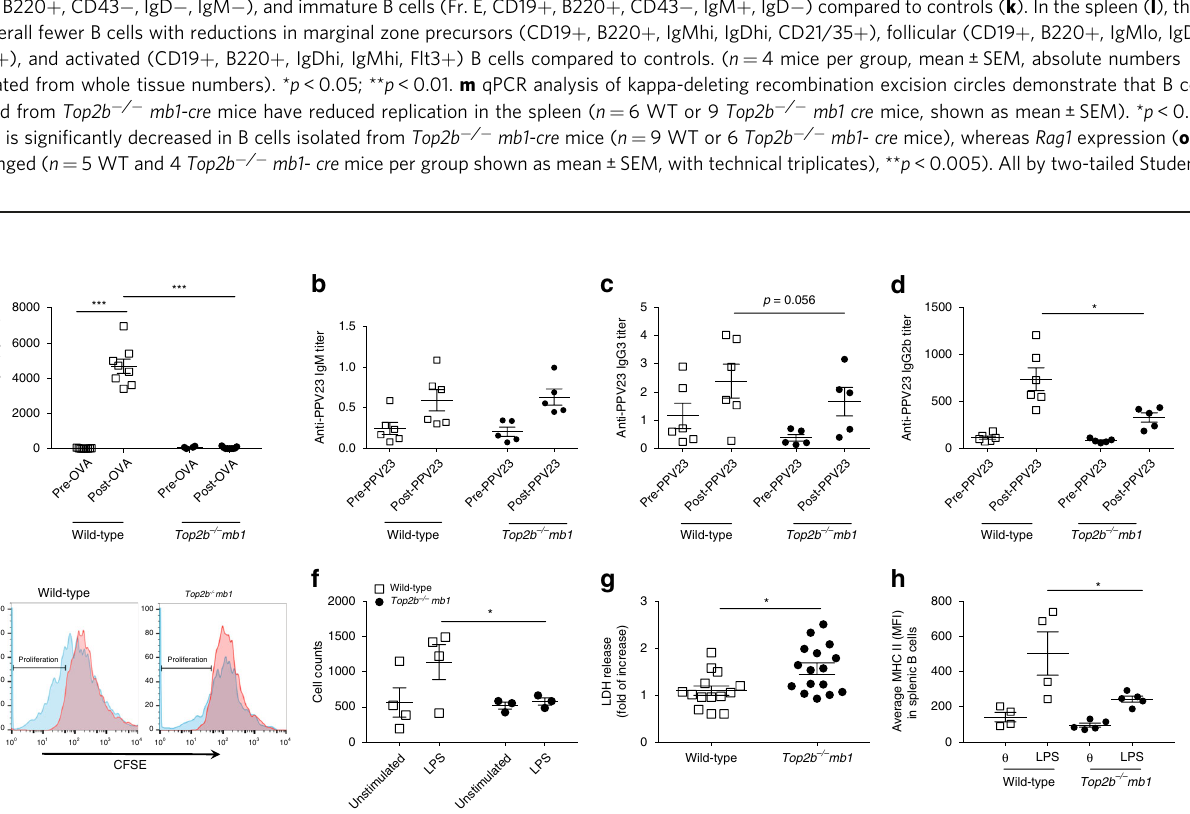
Fig. 4 B cells are functionally impaired in the absence of Top2b, in vivo and in vitro. a Mice fail to produce speci fi c IgG antibody in response to vaccination with ovalbumin (OVA) in the absence of Top2b in B cells ( n = 9 mice per group, shown as mean ± SEM, *** p < 0.005 by the Kruskal – Wallis test). b – d Adult Top2b − / − mb1 cre and littermate mice were immunized with Pneumovax-23 (PPV23). At 6 days post-immunization ( b ), B cells produce PPV23- speci fi c IgM in the absence of TOP2B, at similar levels to wild-type control mice. Four weeks after immunization with Pneumovax-23, anti-PPV23 IgG3 ( c ) and IgG2b ( d ) production is impaired in Top2b − / − mb1-cre mice compared to wild-type control animals ( n = 6 WT or 5 Top2b − / − mb1 cre , shown as mean ± SEM, * p < 0.05 by the Kruskal – Wallis test). e In vitro, Top2b − / − mb1 cre mouse-derived B cells fail to proliferate, as assessed by CFSE dilution, in the presence of stimulation with LPS (blue histogram). Untreated, CFSE stained cells are shown in red. FACS plots are representative of 4 mice per group. Total number of CFSE positive cells is quanti fi ed in ( f ). g Top2b − / − mb1 - cre mouse-derived B cells have increased cell death as measured by LDH